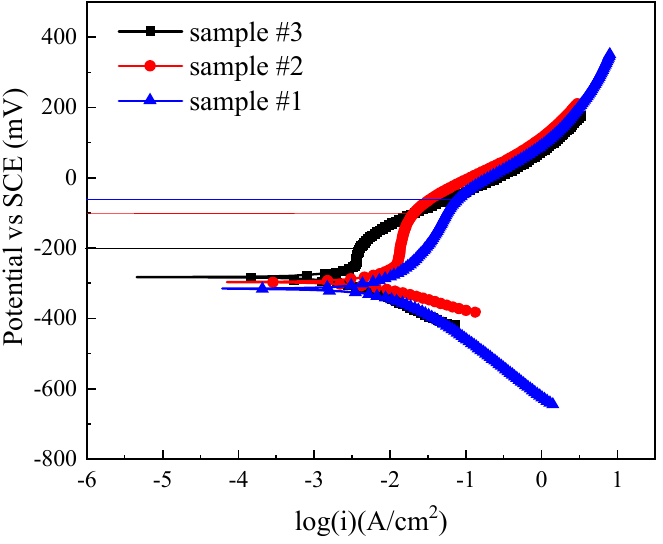
Figure 9. Polarization curves of three weld joint samples. Table 4. Corrosive properties of the weld joints in 3.5 wt.% NaCl solution.